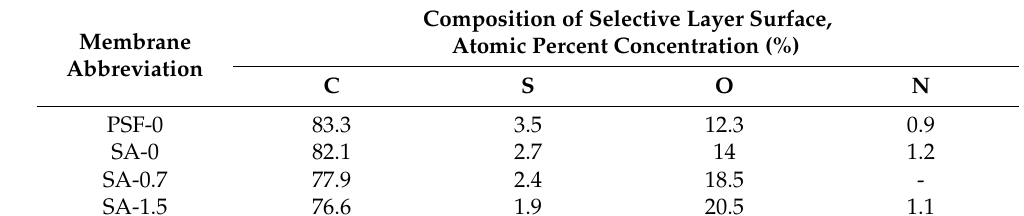
Table 3. Elemental analysis of the surface of the selective layer of pristine PSF membrane,